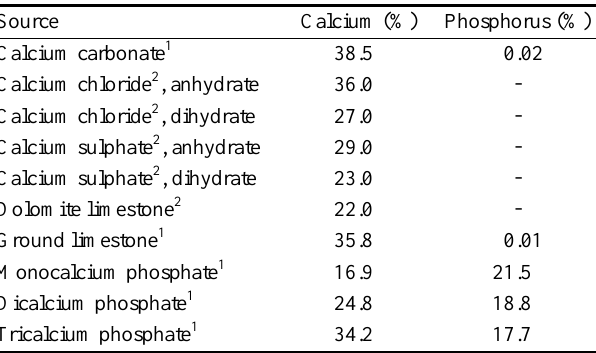
Table 1. Concentration of calcium and phosphorus in inorganic